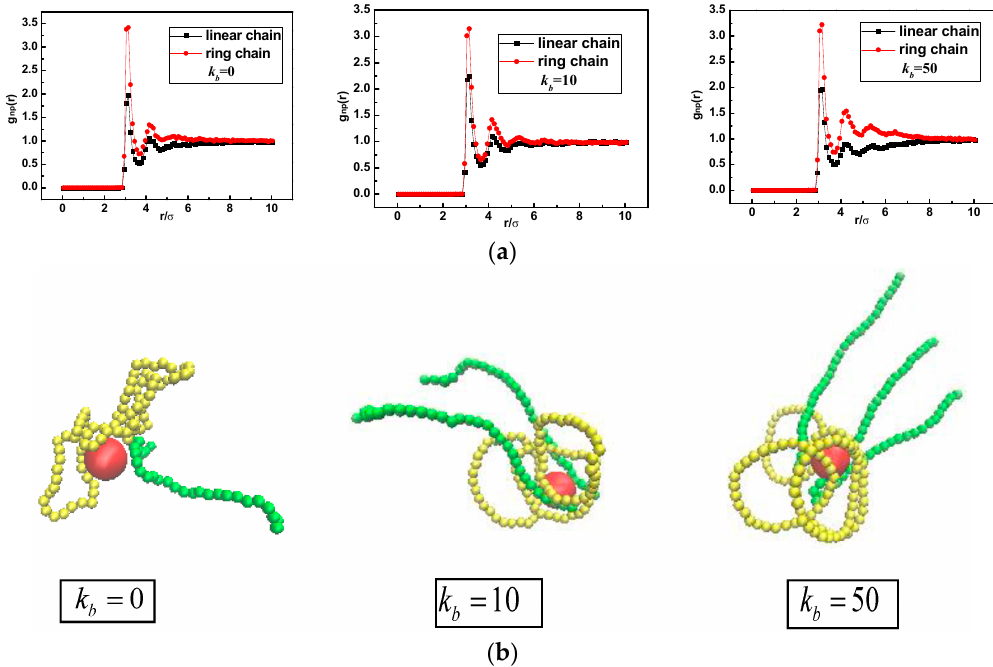
r ; ( b ) snapshots of the conformations of Figure 4. ( a ) Polymer-NP pair distribution function g ( ) Figure 4. ( a ) Polymer-NP pair distribution function g np ( r ) ; ( b ) snapshots of the conformations of np ε nanocomposites with ε np = 1.0. Here ring and linear polymer chain are displayed in yellow and nanocomposites with = 1.0 . Here ring and linear polymer chain are displayed in yellow and np green, green, respectively.